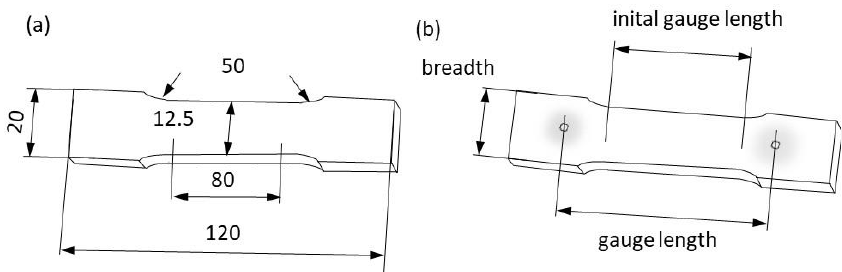
Figure 8. Specimen illustrations: ( a ) sample dimensions, ( b ) schematic illustration of gauging. Table 1. Chemical composition of the material — DC04.